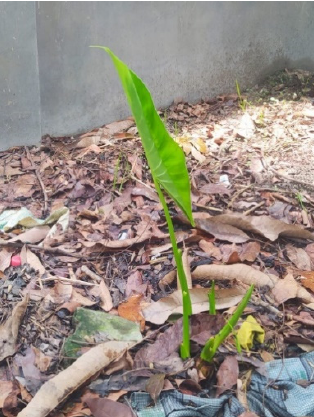
Figure 19. Alt-text: A bright green plant growing in the dirt.